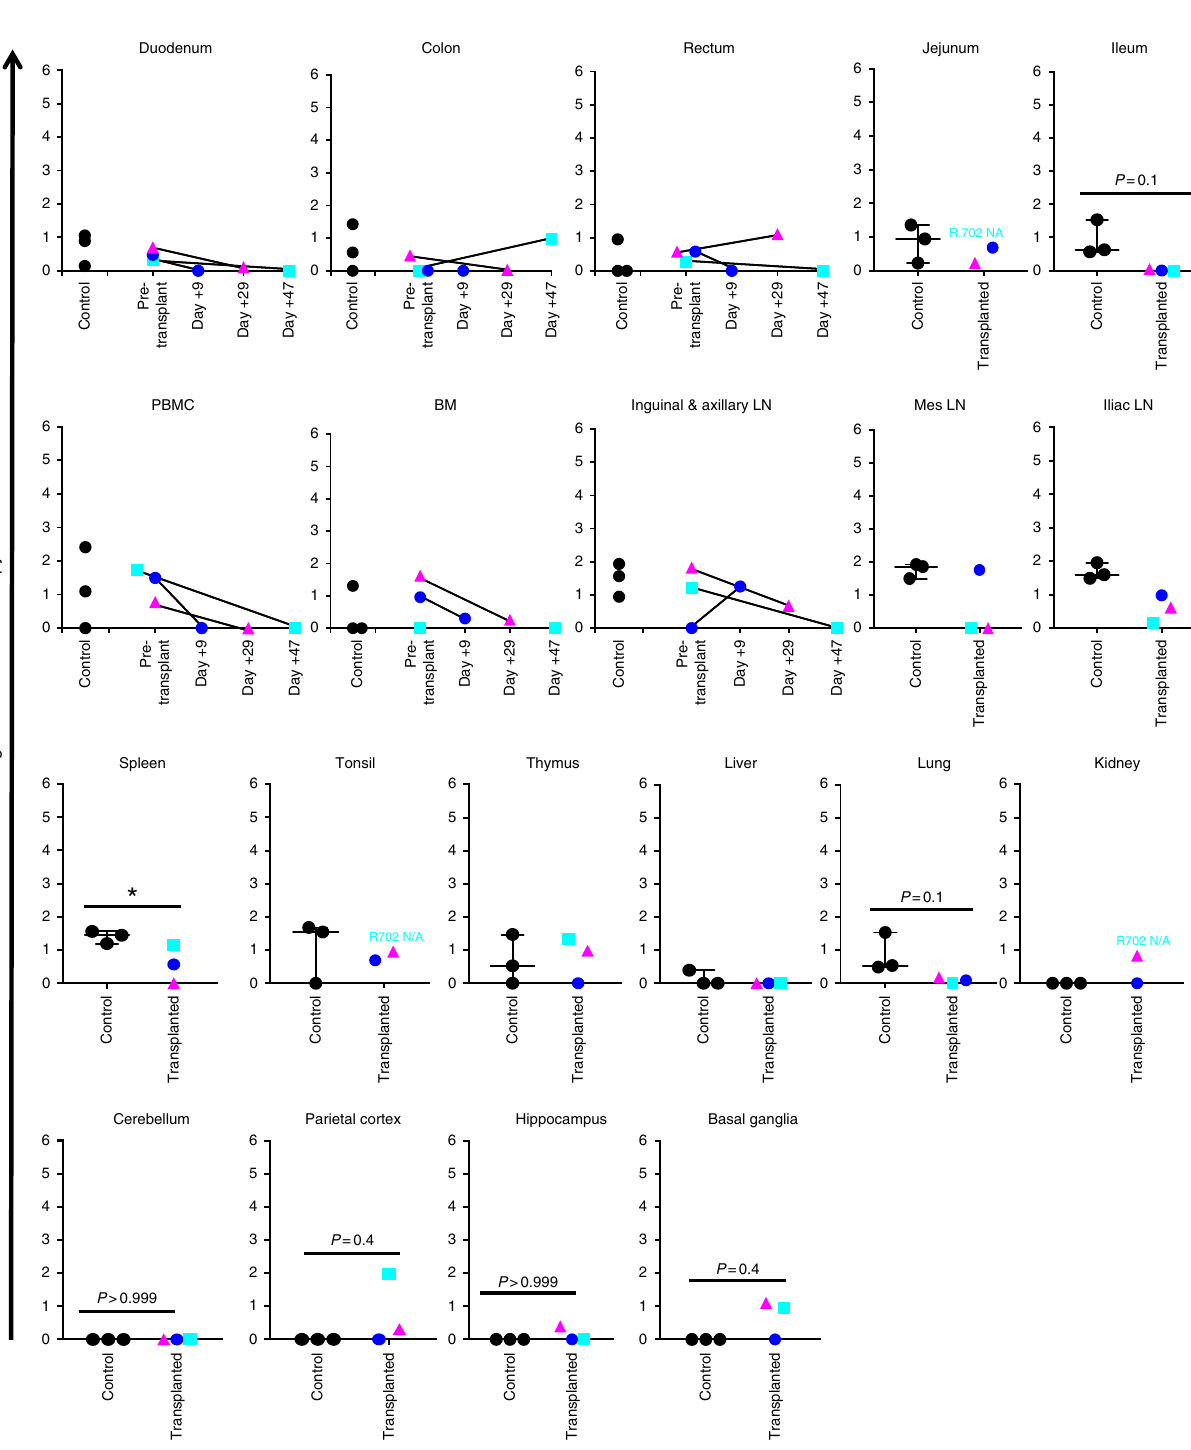
Fig. 5 SHIV-C RNA in transplanted recipients and controls. Total RNA was extracted from the following tissues at necropsy and subjected to qPCR for viral RNA with GAG-speci fi c primers: PBMC, BM, pooled inguinal and axillary LN, duodenum, colon, rectum, mesenteric LN, iliac LN, spleen, tonsils, thymus, liver, lung, kidneys, jejunum, ileum, cerebellum, parietal cortex, hippocampus, basal ganglia. Where applicable, measurements at multiple time points in transplanted animals are indicated. Error bars represent the mean with SEM. Spleen: p = 0.0489, t = 2.799, df = 4, unpaired two-tailed t